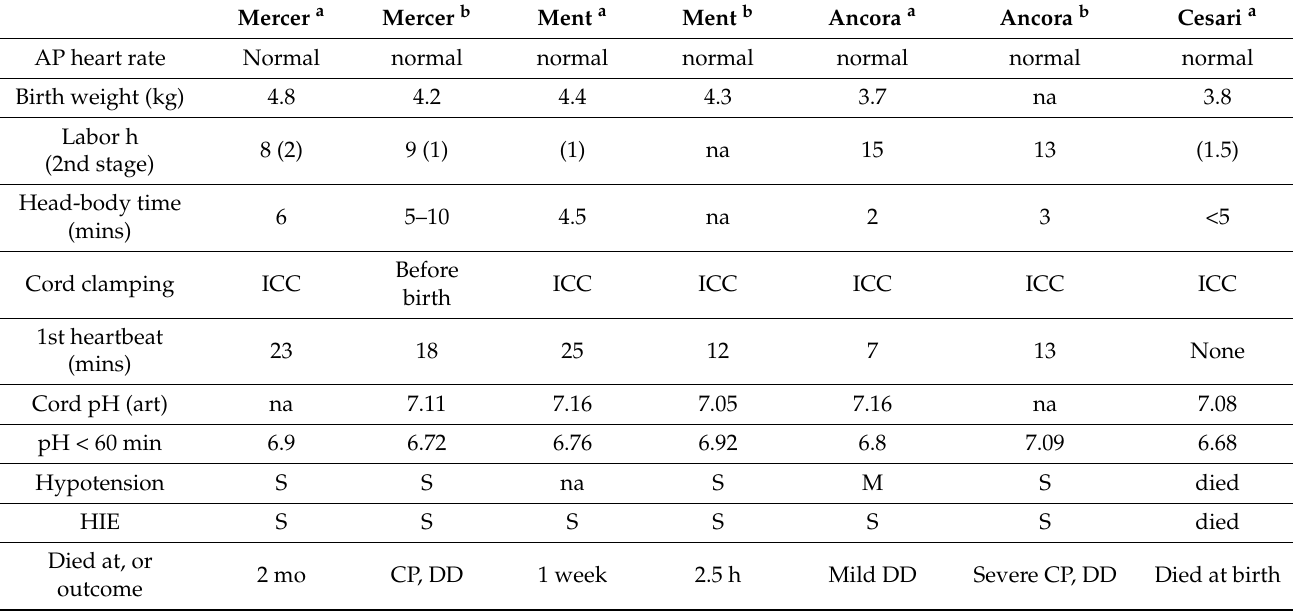
Table 1. Commonalities between newborn cases of Sudden Cardiac